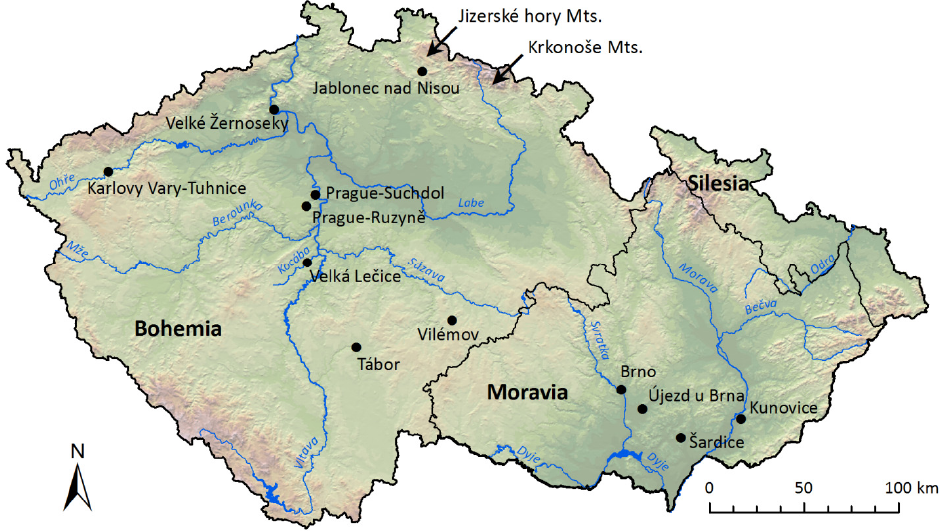
Figure A1. Location of places, mountains, and rivers in the Czech Republic reported in this study.